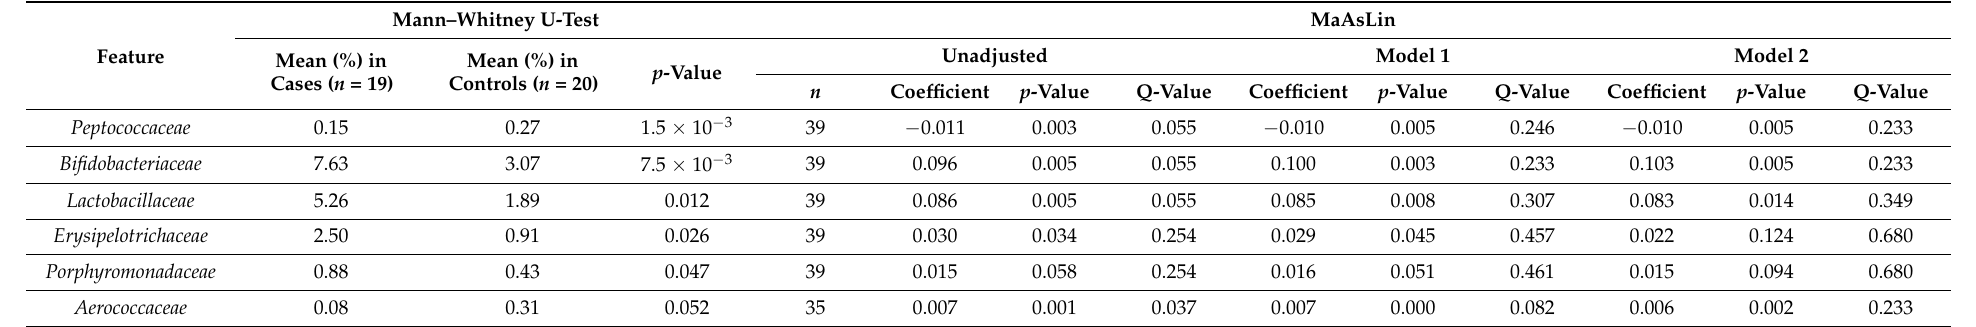
Table 3. Statistically significant differences between PCOS cases and controls in the relative abundancies at the family